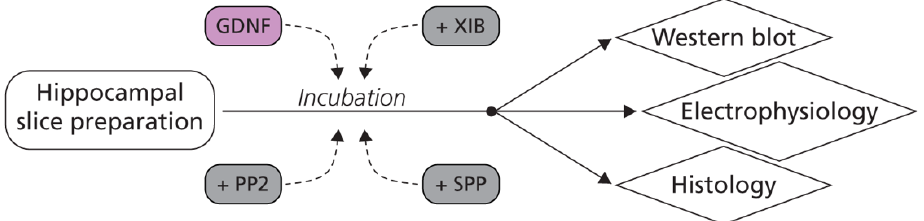
Figure 10. Graphical illustration of experimental methods. After slice preparation (from mouse or human tissue), slices were incubated with GDNF, XIB4035, PP2, SPP86, or combinations for 1 h before being processed for either Western blot, electrophysiology, or histology experiments.